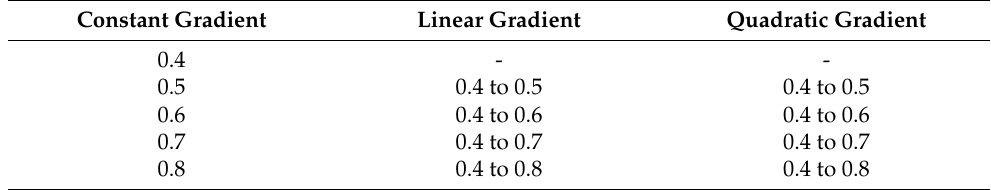
Table 2. Created gyroid structures: constant gradient, linear gradient, quadratic gradient.